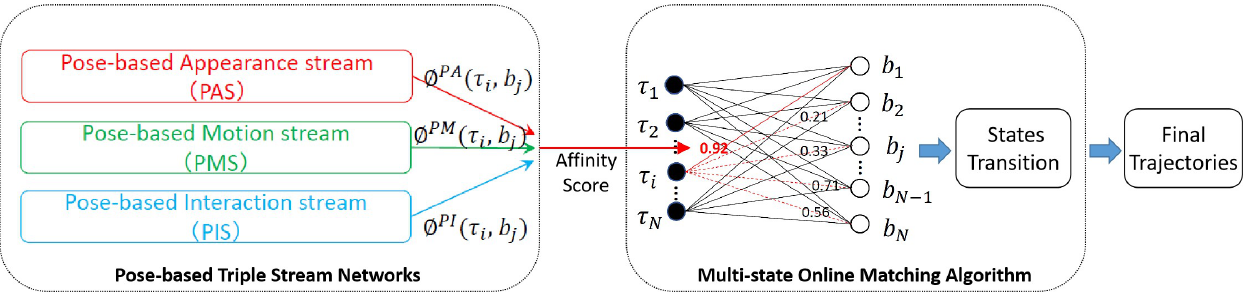
Figure 1. The proposed Multi-Athlete Tracking